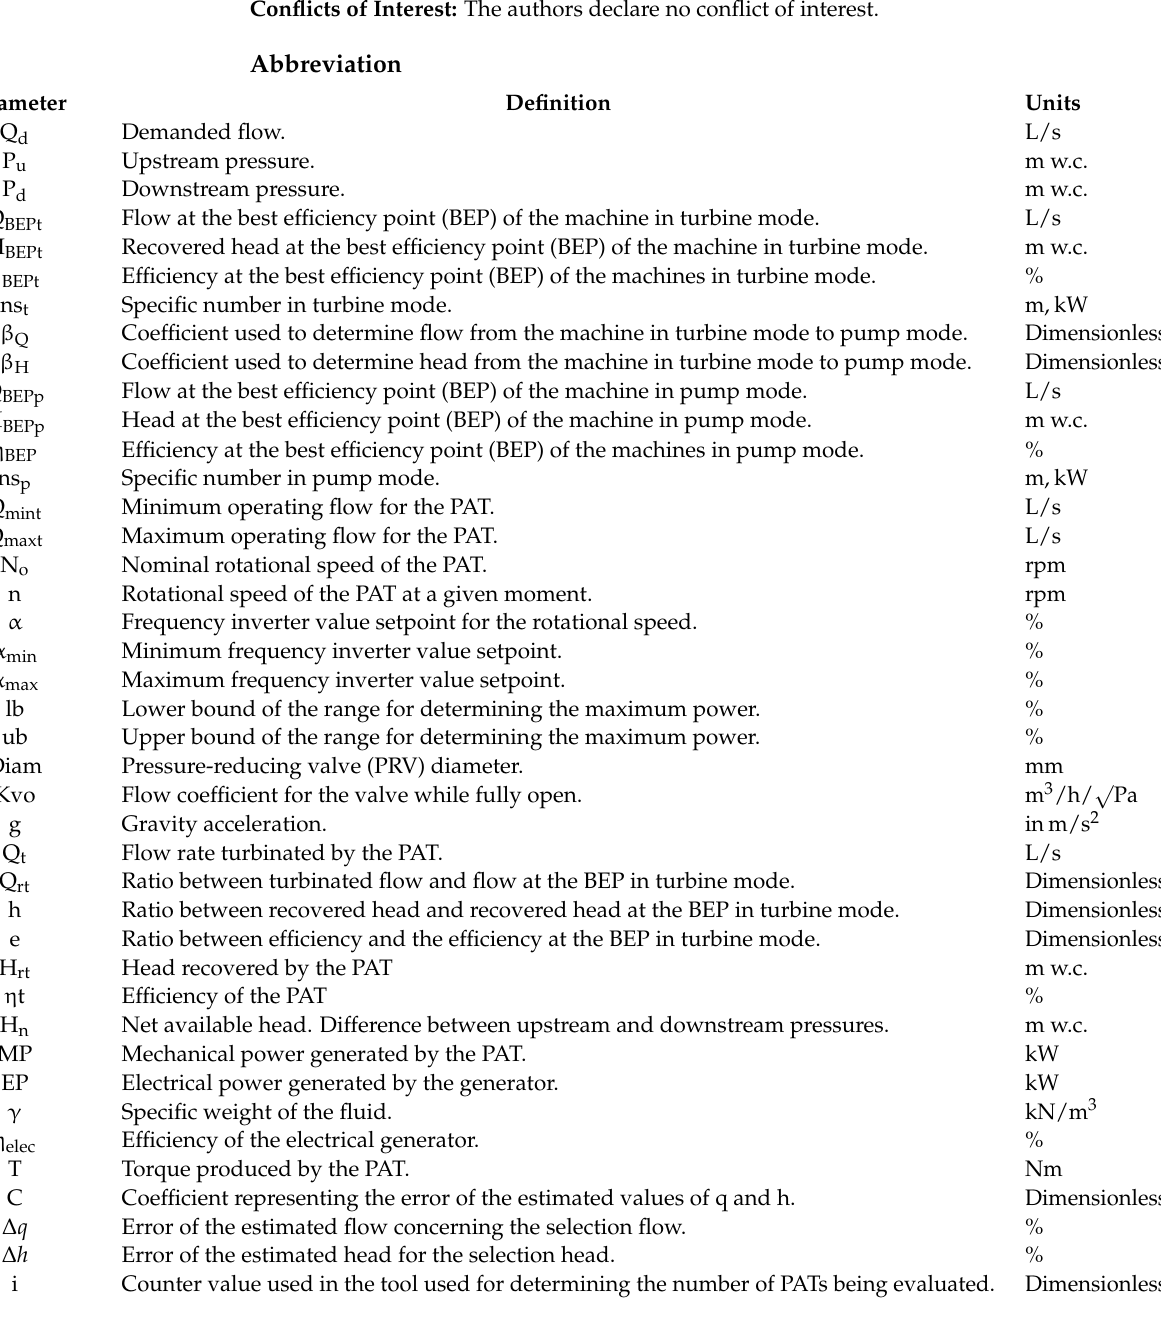
∆ q Error of the estimated flow concerning the selection flow. Error of the estimated head for the selection head. Counter value used in the tool used for determining the number of PATs being evaluated.